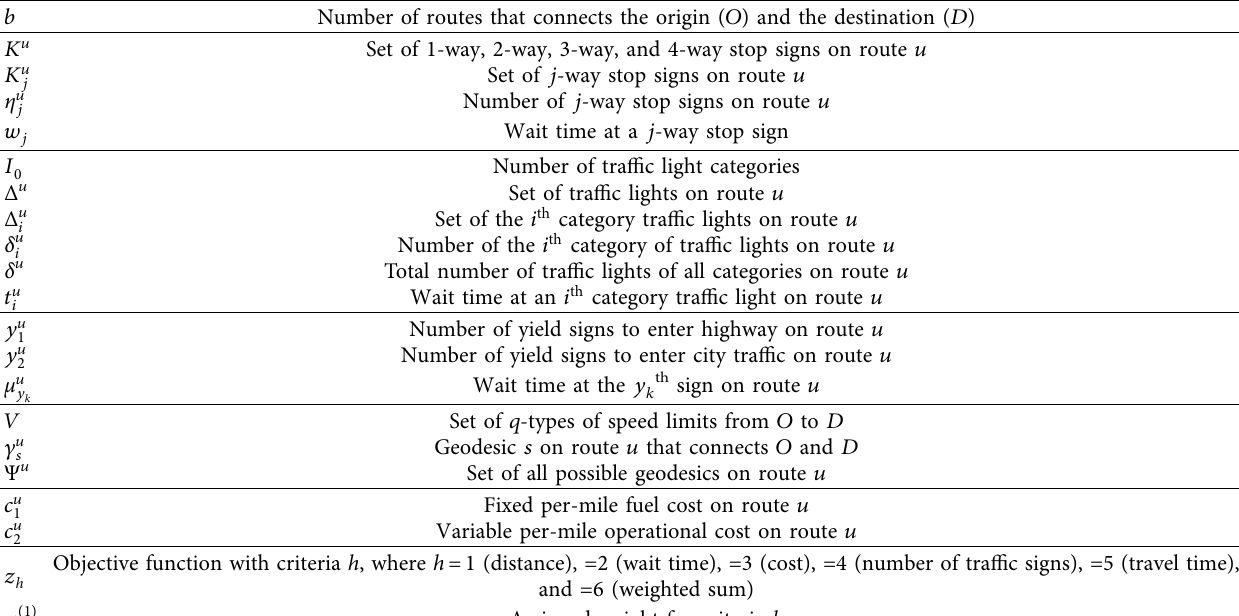
Table 4: A summary of model